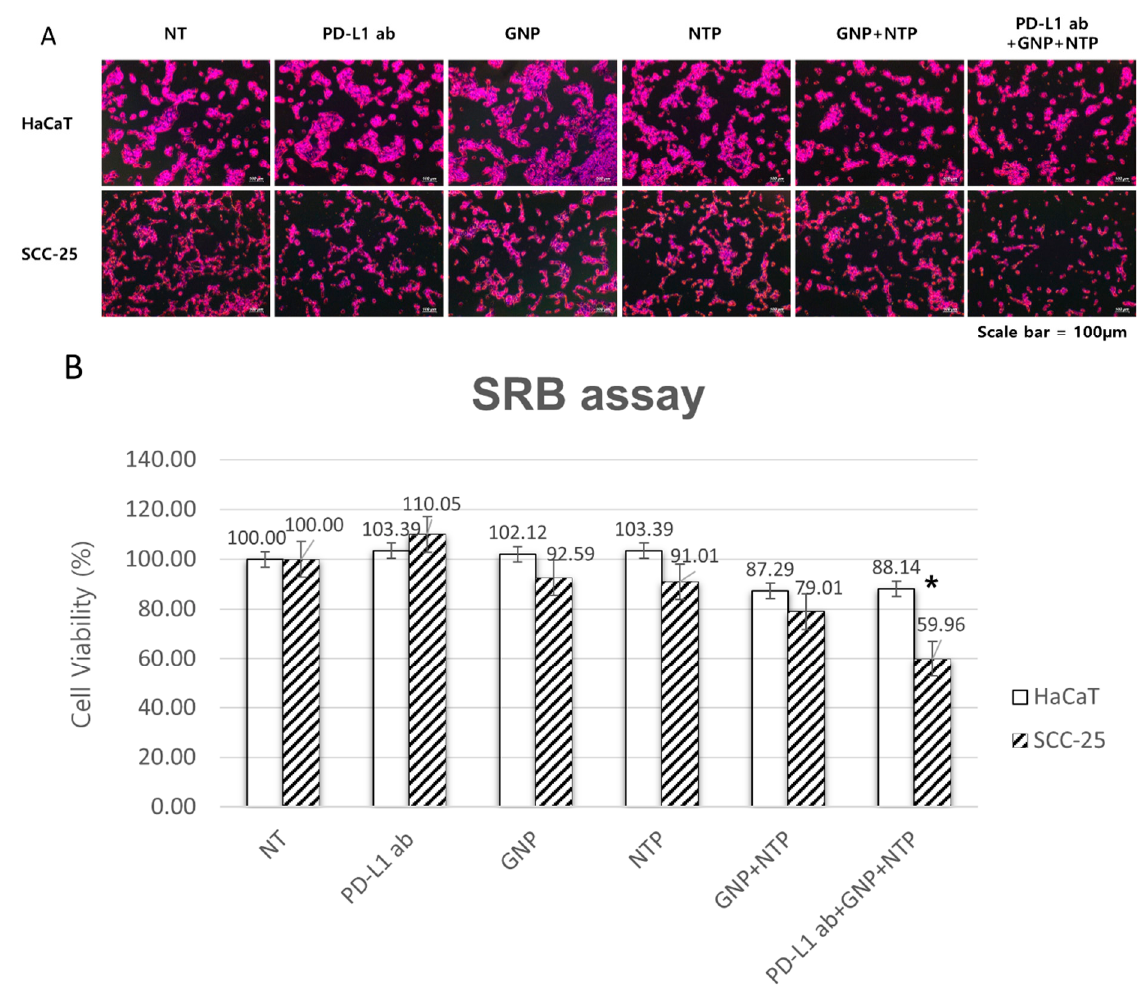
Figure 4. Effect of PD-L1 ab + GNP + NTP on the cell viability of SCC-25 cells and HaCaT cells. ( A ) According to the SRB assay, SCC-25 cells overall showed lower cell viability compared to HaCaT cells. Least number of cells were observed after PD-L1 ab + GNP + NTP treatment. ( B ) Data shown represent three independent experiments. * p < 0.05, statistical difference using a paired t -test. Abbreviations: NT, nontreatment; ab, antibody; GNP, gold nanoparticle; NTP, nonthermal plasma.